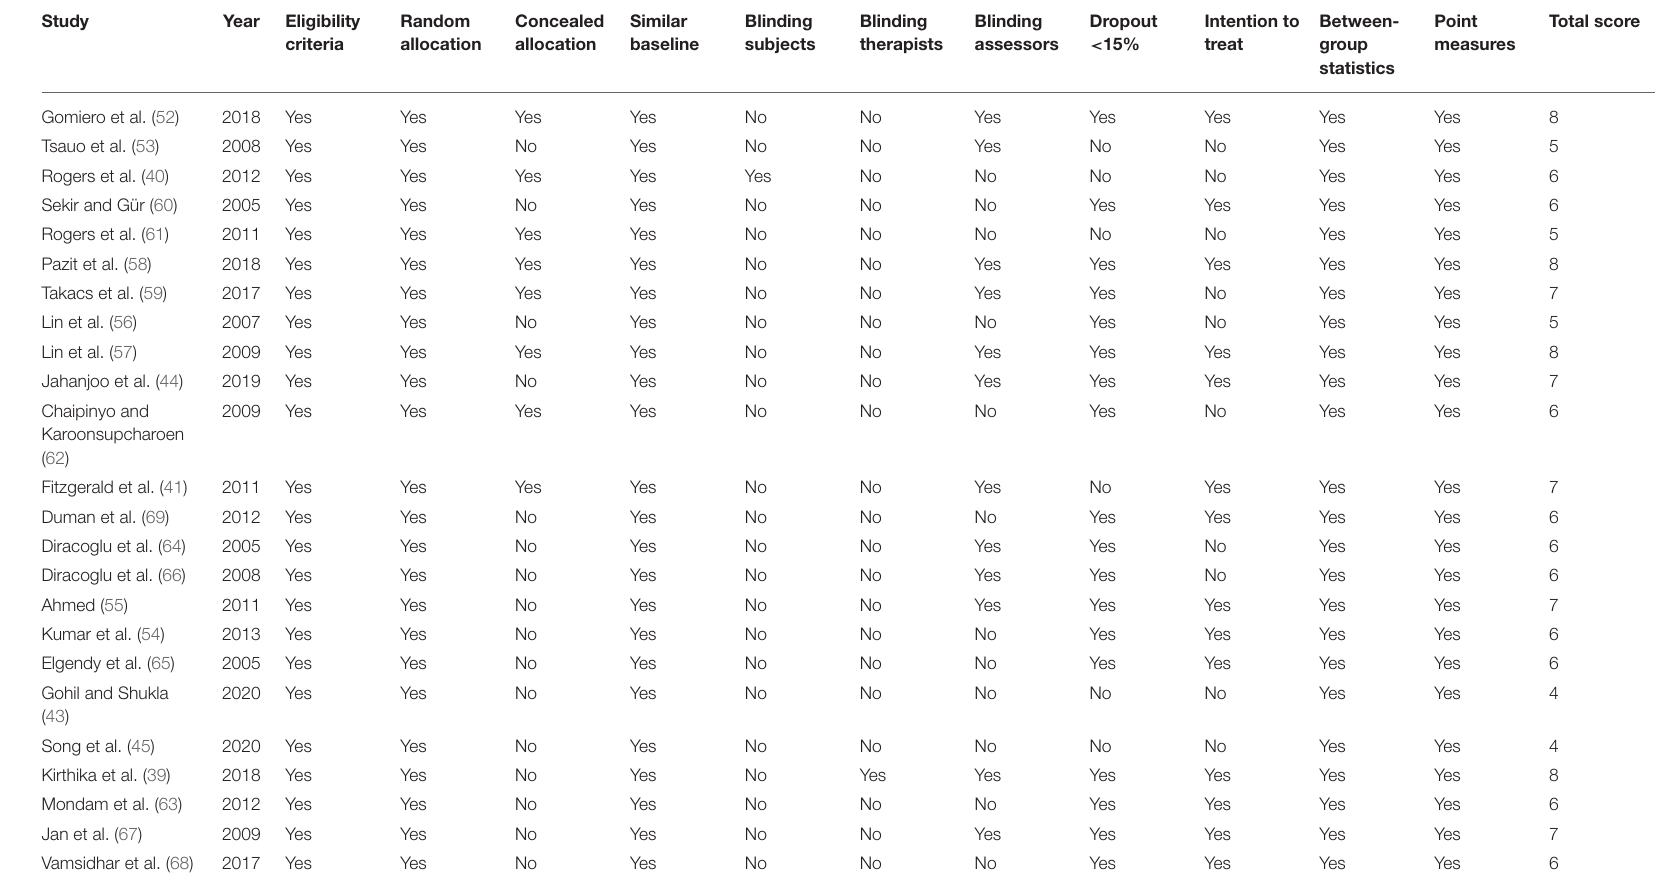
TABLE 2 | PEDro scores of the included